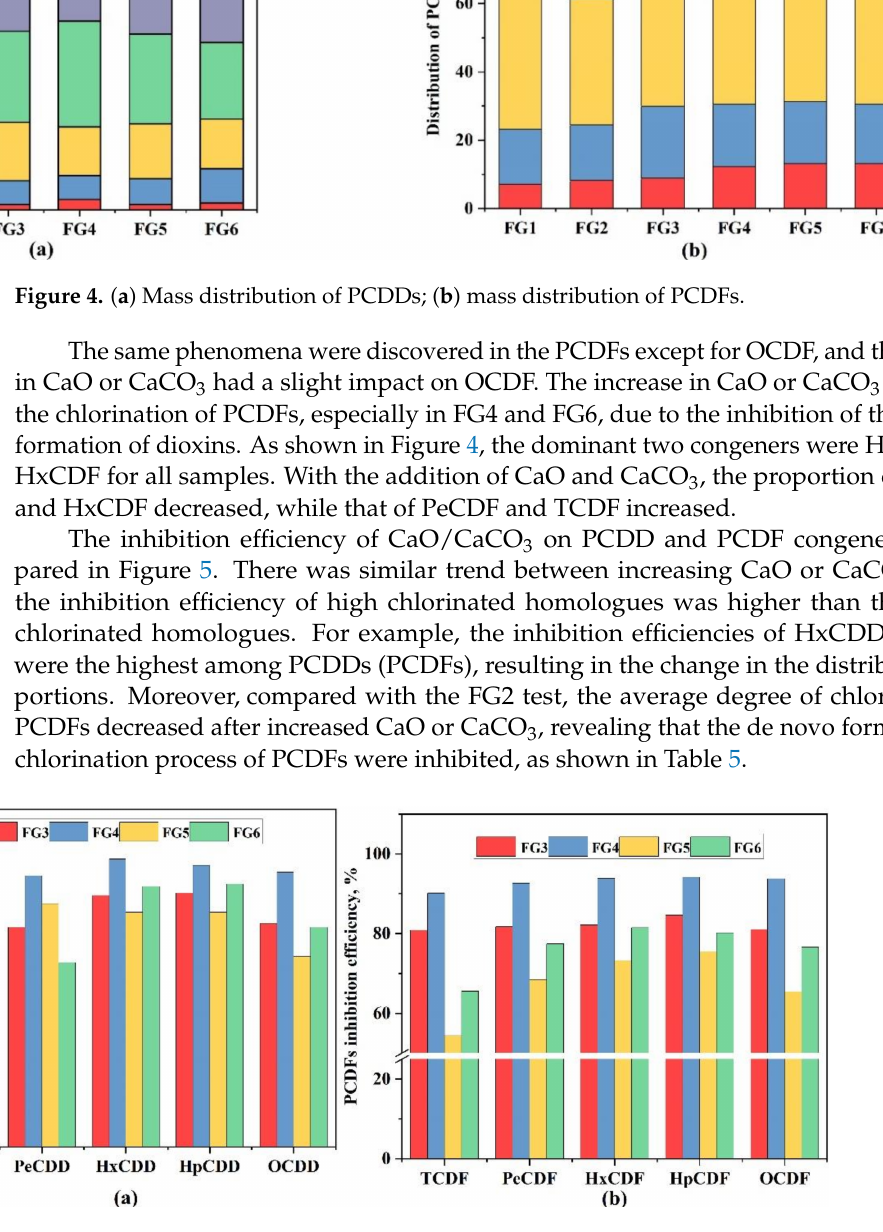
Figure 5. ( a ) The efficiency of PCDD congener inhibition. ( b ) The efficiency of PCDF congener